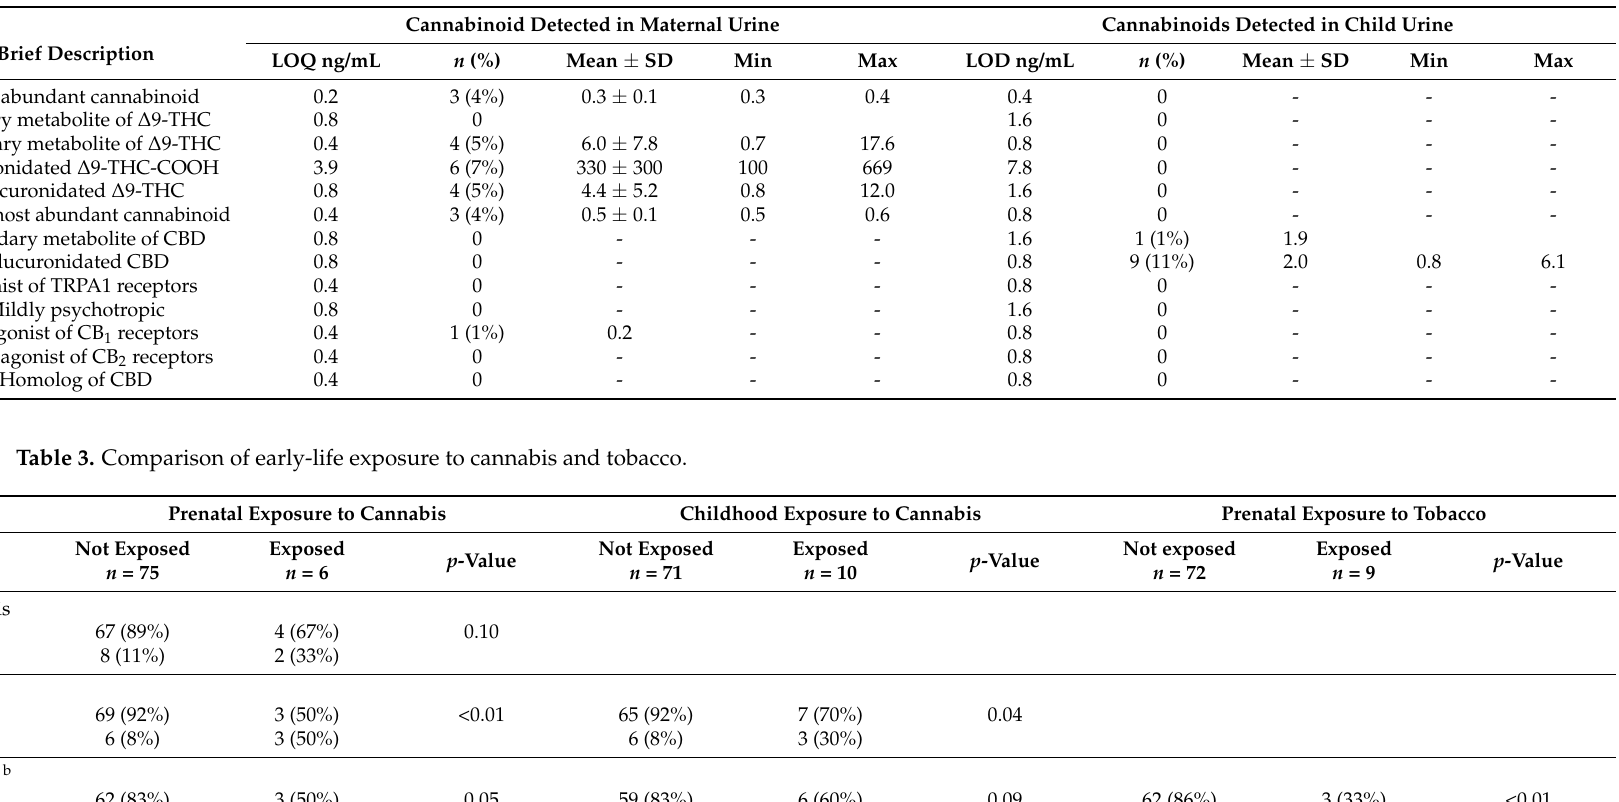
Table 2. Cannabinoids/metabolites detected in maternal and child urine samples.